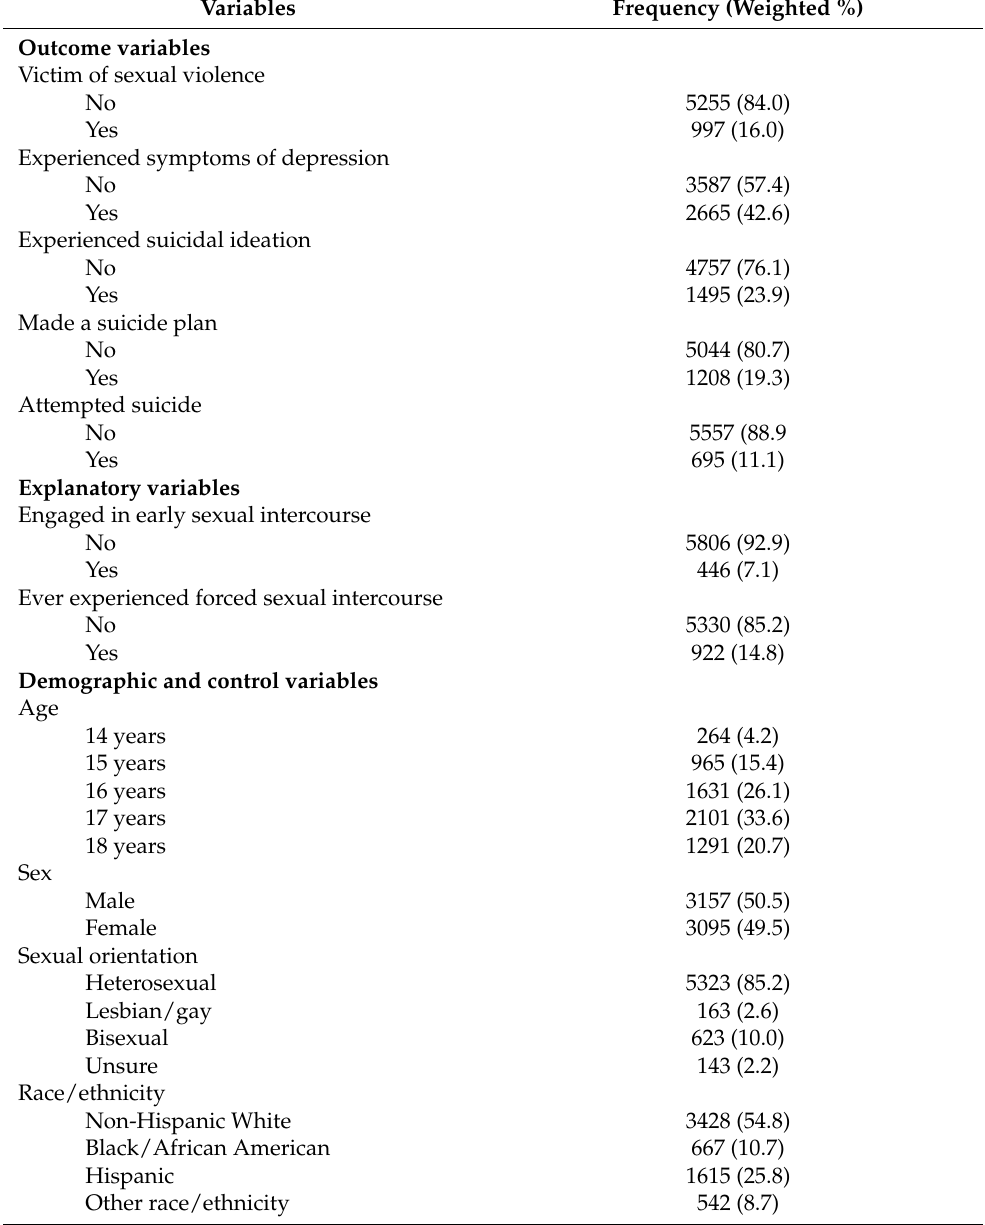
Table 1. Sample characteristics among adolescents aged 14–18 who had ever had sex ( n =